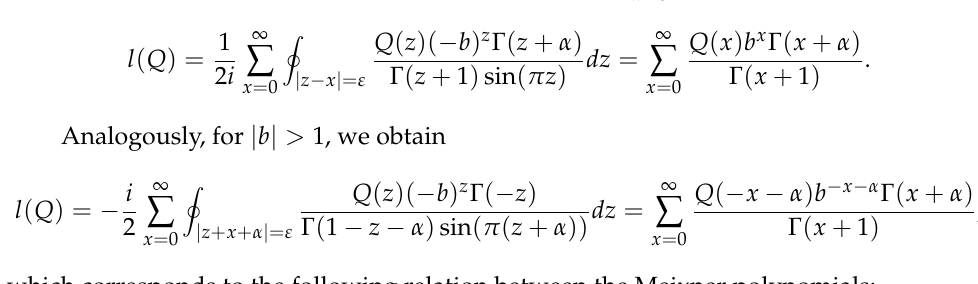
Figure 2. The curve L suitable for the Meixner weight if b ∈ C \ ( 0, + ∞ ) ( left ) and if | b | < 1 ( right ). For | b | (cid:54) = 1, the integral l ( Q ) may be calculated using the Cauchy theorem. Indeed, according to (a), for 0 < | b | < 1 and any ε ∈ ( 0, 1/2 ) , the curve L may be replaced (without changing the integral’s value) with the union of circles (cid:83)